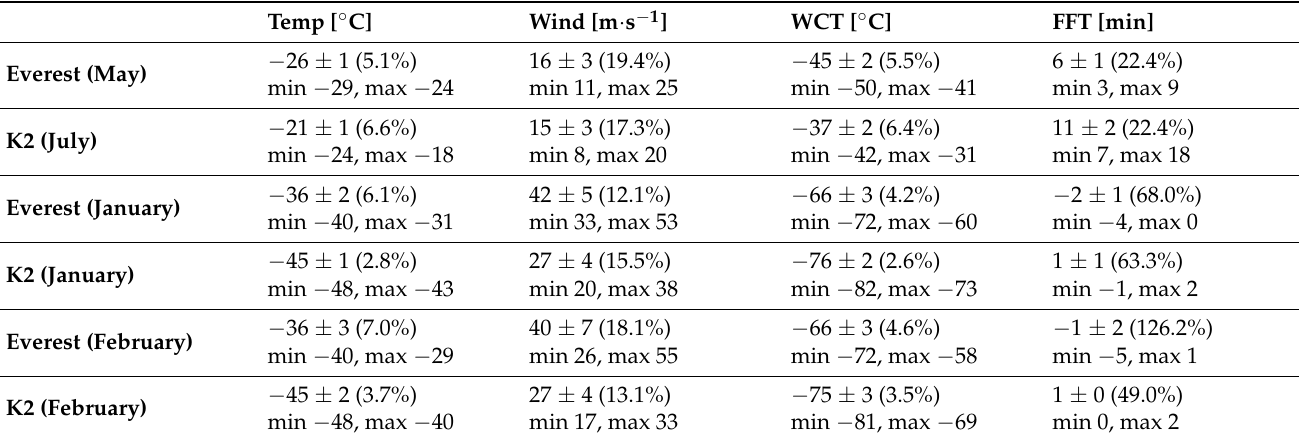
Table 2. Ambient temperature, Wind, and thermal stress indices: WCT and FFT for the months we analyzed: monthly means ± standard deviation (SD), coefficient of variation (CV%), minimum and maximum values. Sample size—41 monthly means